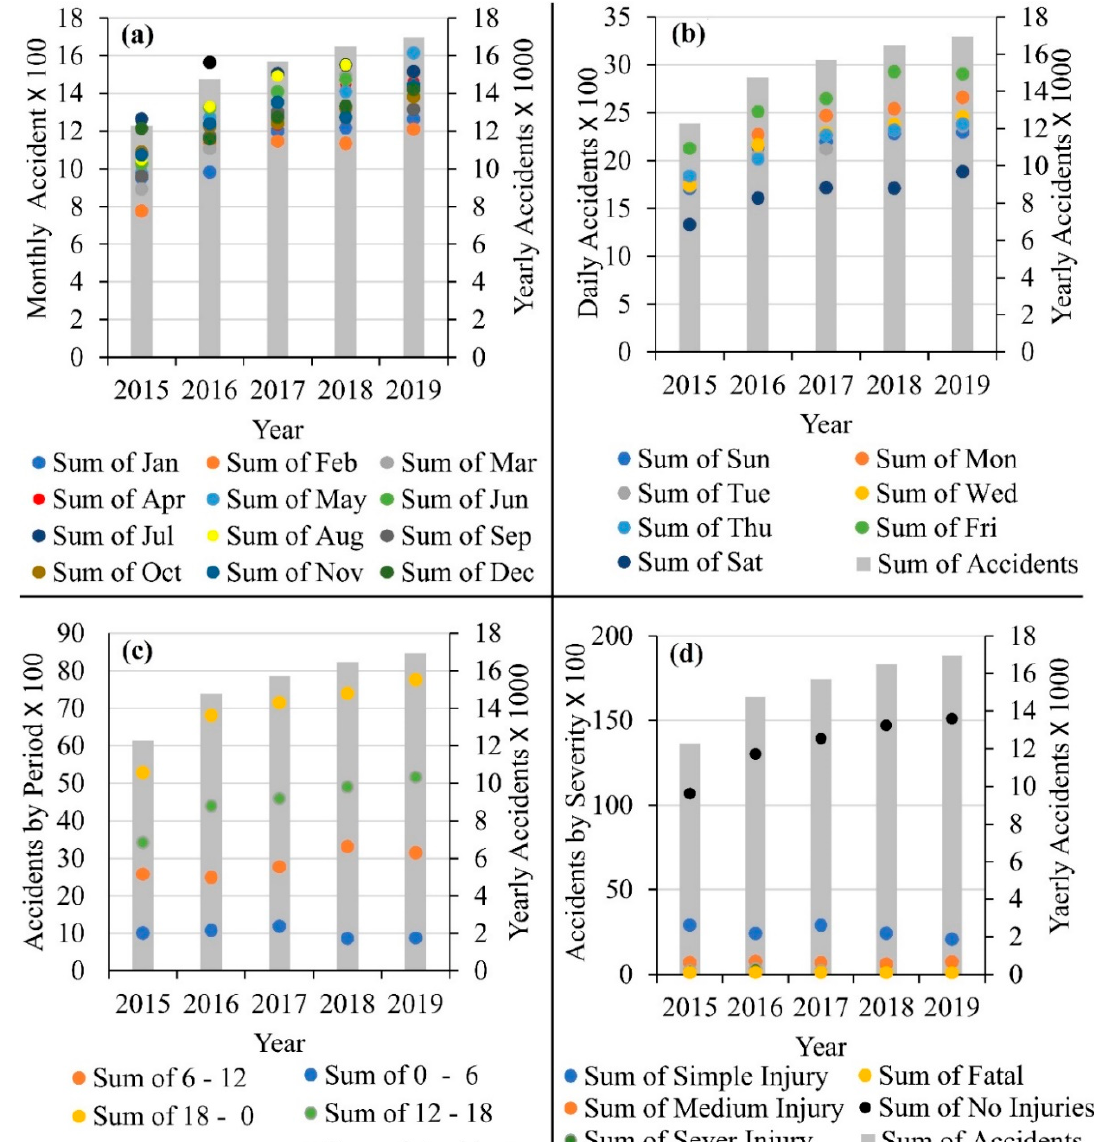
Figure 5. Distribution of traffic accidents in the Irbid Governorate at ( a ) monthly, ( b ) daily, ( c ) period of the day, and ( d ) severity level. The grey columns represent the total number of accidents at the year level.